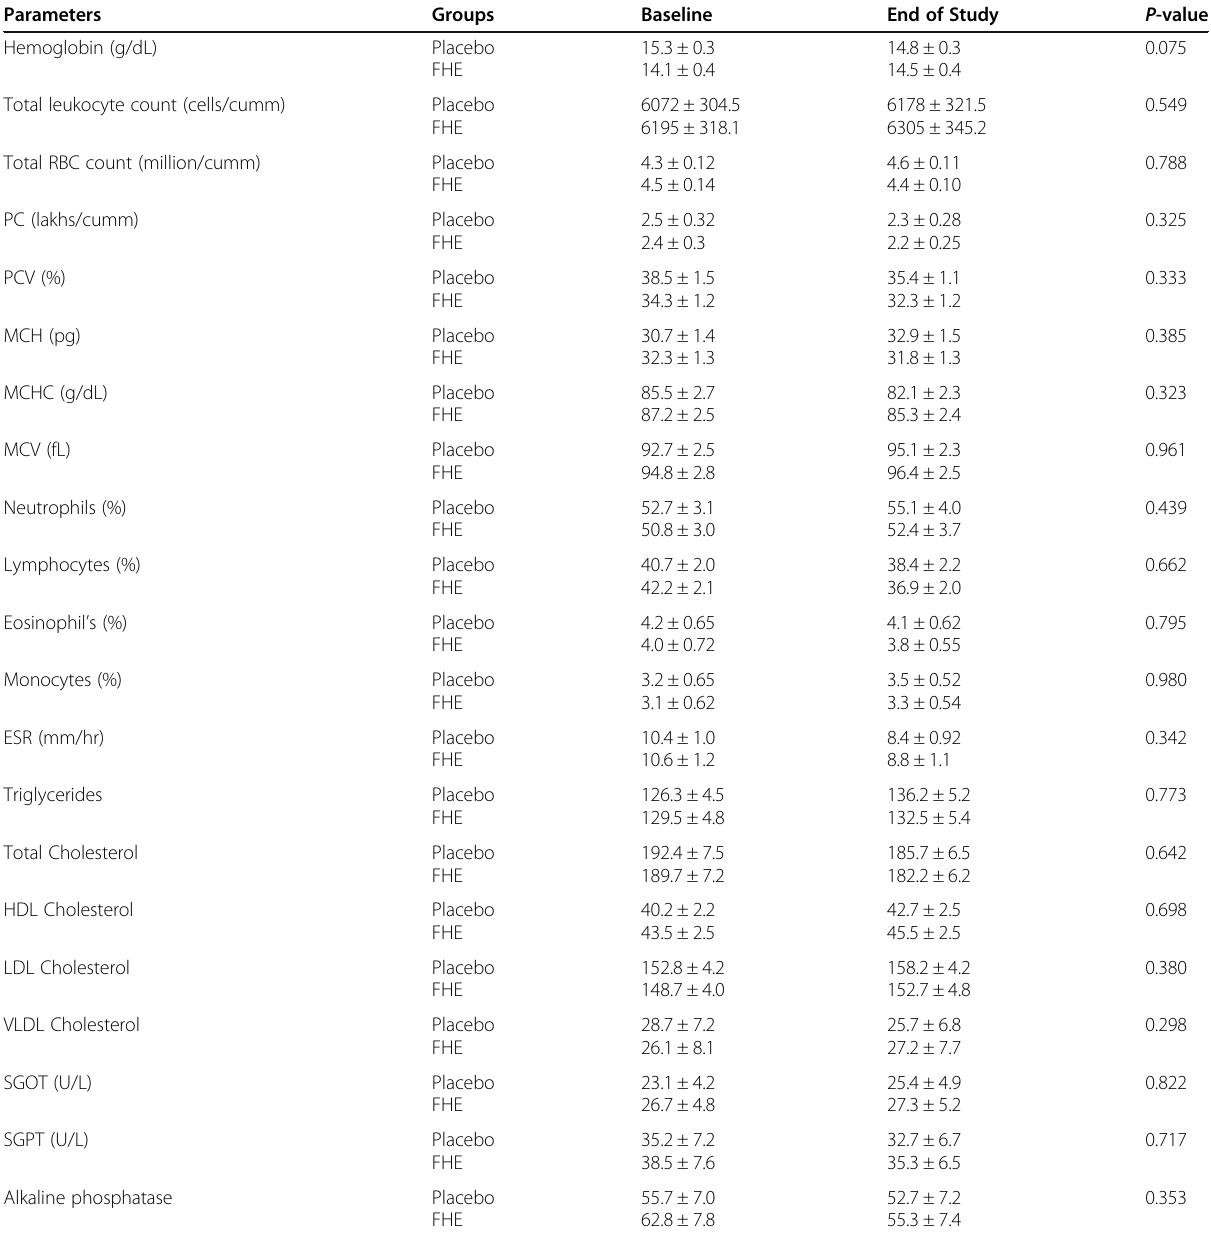
Table 4 Hematological and biochemical parameters in FHE and placebo Parameters Groups